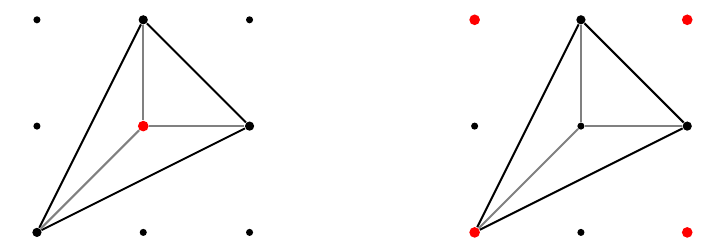
Figure 4. The toric involution on the toric diagram of the resolved C 3 = Z 3 orbifold theory, with the (cid:12)xed points displayed in red. On the left the resolved orientifolded theory with a compact (cid:10)7, while on the right it is showed the resolved unoriented theory with a non-compact (cid:10)7 and a (cid:10)3.